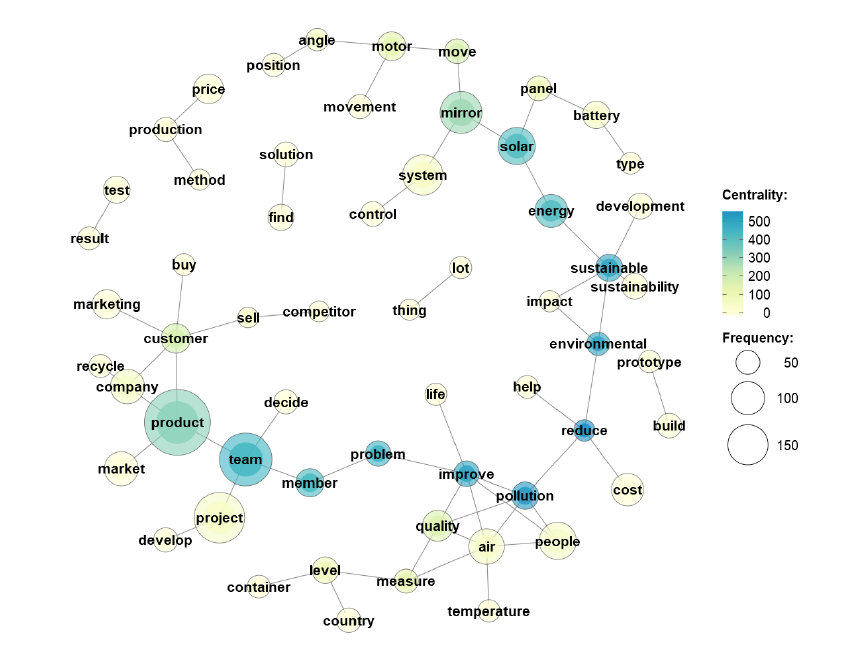
Fig. 6. Term frequency, centrality and co-occurrence network of the three reports Term centrality is represented through colour, with the darker hue indicating terms with a central role and lighter hue terms with a peripheral role. The most central terms are team , member , problem , improve , pollution , reduce , environmental , sustainable , energy and solar , indicating that sustainability was a pervasive